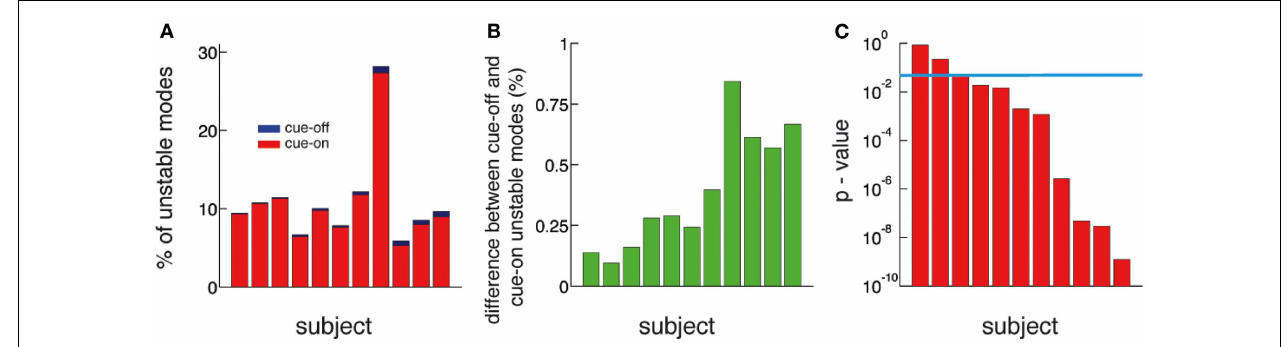
Difference between the % of unstable nodes in cue-off and cue-on conditions.This quantity is always positive, therefore there is always more unstable modes in cue-off than in cue-on periods. (C) The differences in the distribution of unstable modes is significant in 8 of 11 subjects. ( p < 0.05, Kolmogorov–Smirnov test, blue line: p = 0.05).